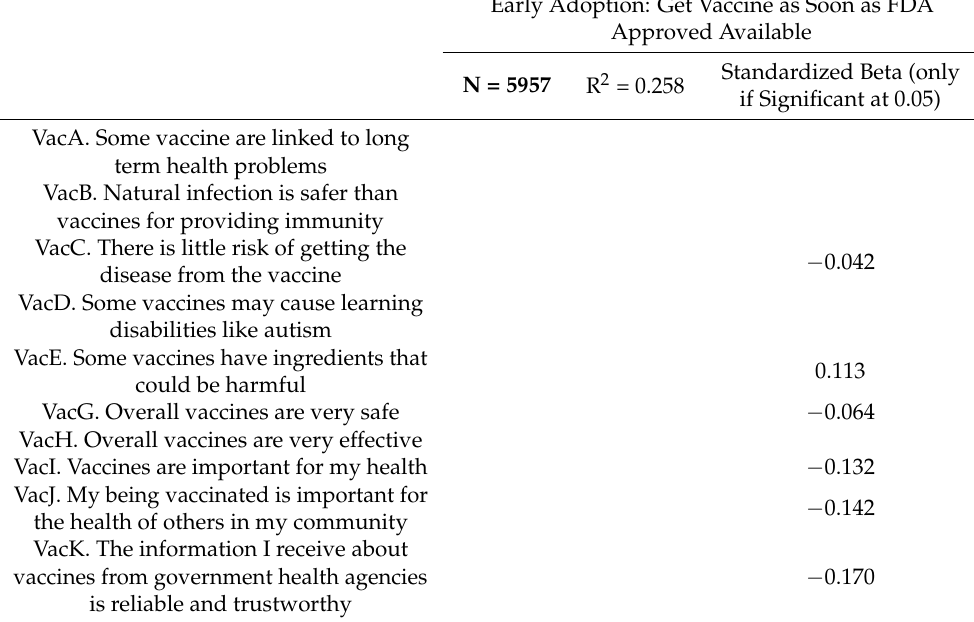
Table 8. Regression of Likelihood of Vaccine Adoption (Very, Somewhat, Not Too, Not at All) by General Beliefs toward vaccines.